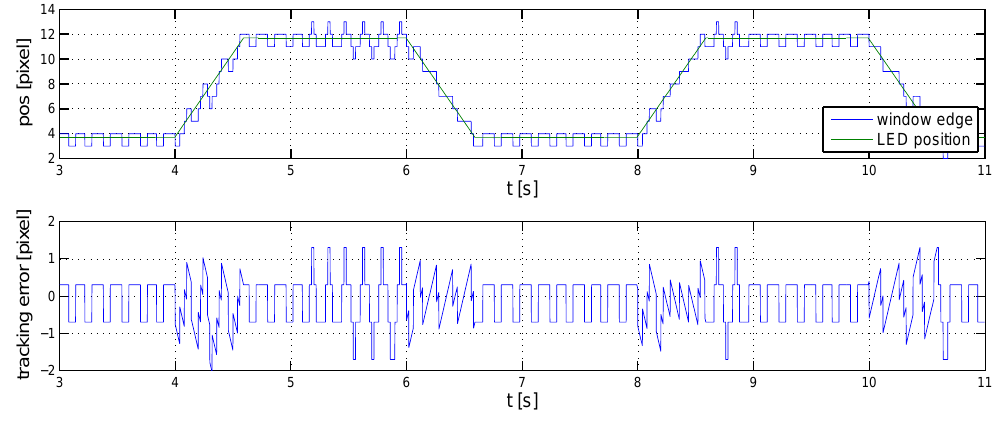
Figure 9. Initial controller, nonlinear simulations.